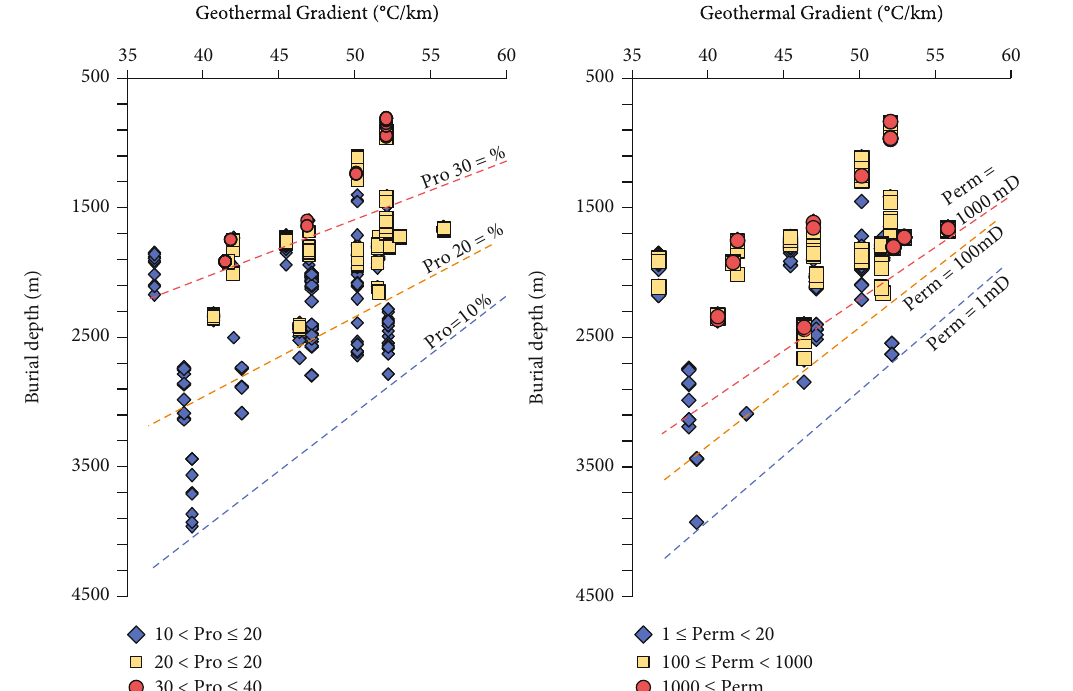
Figure 9: The variation of the limit burial depths of samples with the same porosity and permeability in di ff erent geothermal gradient regions (modi fi ed from [22]).